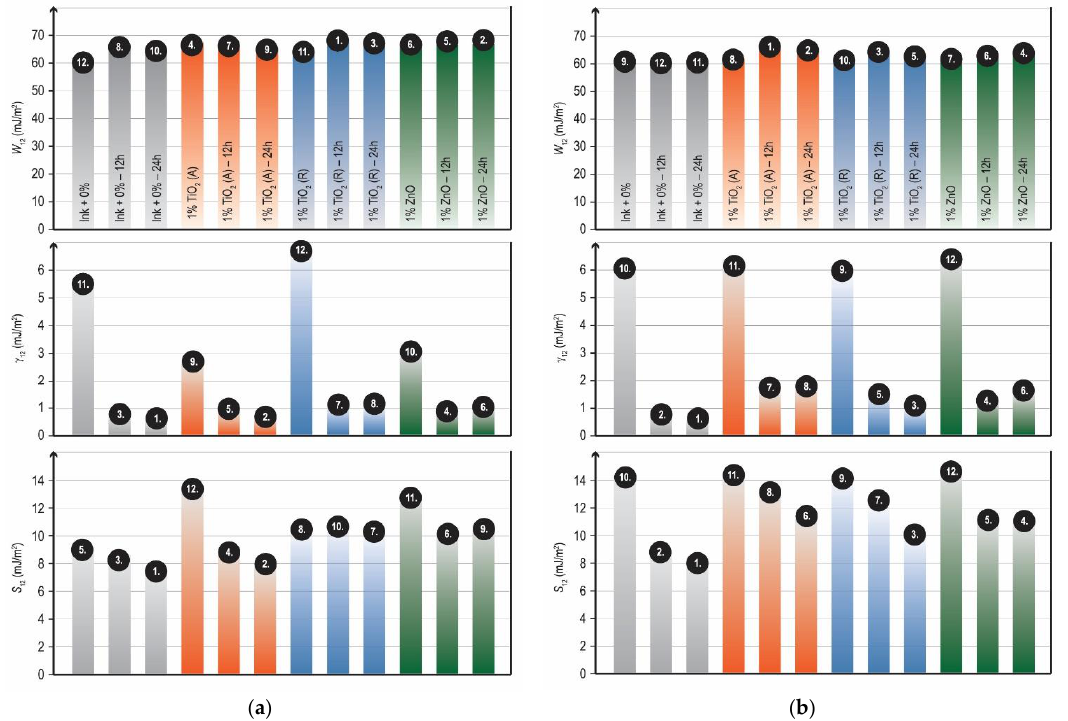
Figure 8. Adhesion parameters of the unmodified and modified ink films without and with addition of nanoparticles on ( a ) uncoated and ( b ) coated paperboards. The UV inks used in this research consist of monomers, prepolymers/oligomers, pig- ments, additives, and photo initiators. During UV irradiation, polymerization takes place in the structure of the ink, resulting in a crosslinked structure, i.e., a firm ink film on the substrate [47]. With additional surface modification, the ink structure apparently changes uniformly on both paperboards and forms an ink film with lower values of the SFE of the interface, indicating better adhesion of the observed films. By analyzing the results of the work of adhesion ( W 12 ), which should be as high as possible to indicate good adhesion, one can see that there are some differences between the “ink–substrate” pairs. For modified inks with rutile TiO 2 and ZnO nanoparticles ap- plied to uncoated paperboard, the work of adhesion is higher, indicating better adhesion after 12 and 24 h of surface modification compared to coated samples. On coated paper- board, the work of adhesion has the highest values for samples with the addition of ana- tase TiO 2 in the ink film. When evaluating the results of the wetting coefficient ( S 12 ), all samples have a positive value, indicating good adhesion of the samples after surface mod- ification. 3.2.3. Mechanical Properties An important property of all printed ink films is a good bond with the substrates so that they do not detach from the surface in end-use situations. After the samples were subjected to the surface modification process, the rub resistance test was performed. Table 8 shows the results of the visual evaluation of the unmodified and modified ink films. It